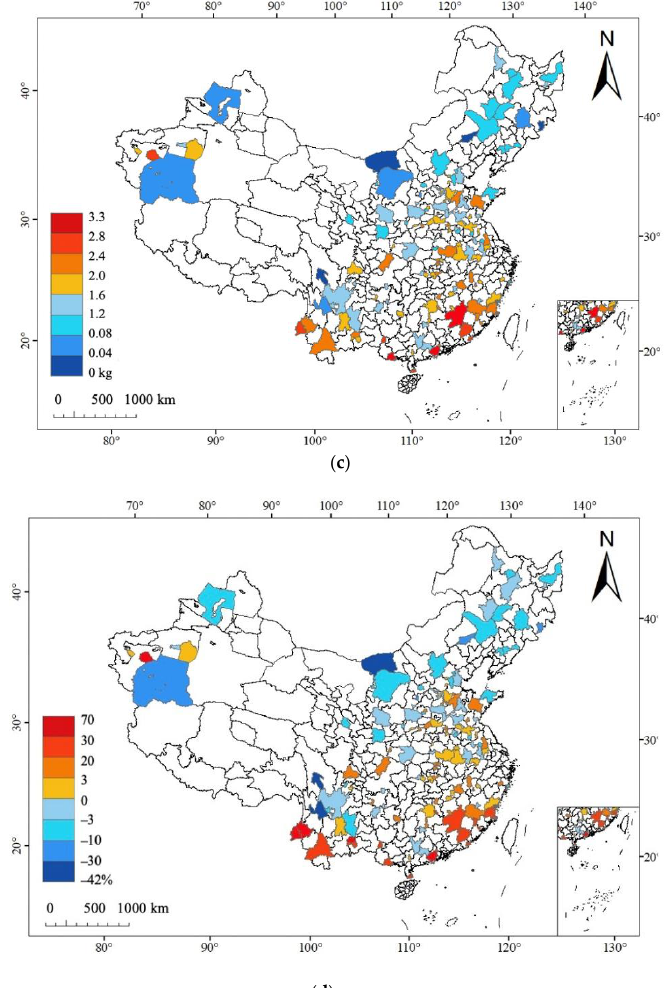
Figure 6. Cooling and heating load-related coal consumption simulated with ( a ) urban air temperature and ( b ) rural air temperature. ( c ) The differences between urban coal consumption ( CC u ) and rural coal consumption ( CC r ) indicate the effect of UHII on coal consumption in a typical residential building. ( d ) The relative change in coal consumption due to UHII, i.e., ( CC u − CC r )/ CC r .